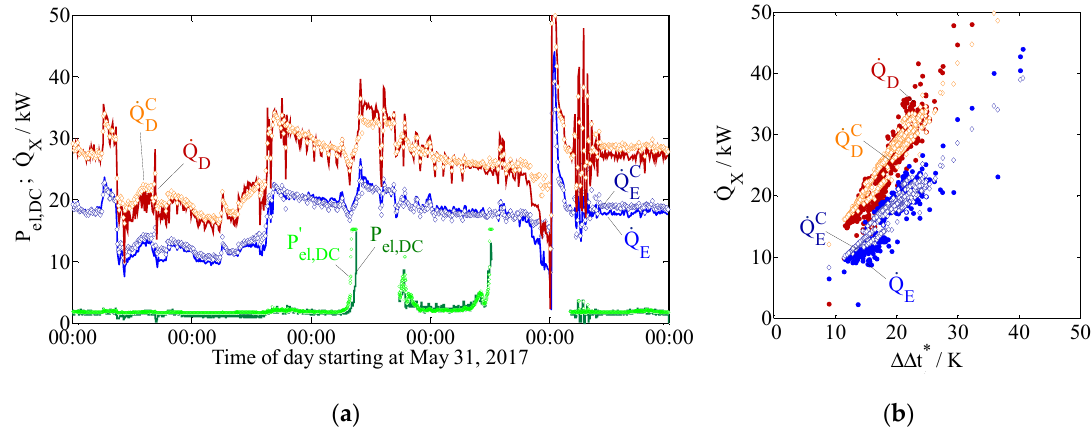
Figure 4. Comparison of the measured and calculated values for the absorption chiller and dry-cooler model as a function of time ( a ) and for the absorption chiller as a function of the inlet characteristic temperature difference ( b ).